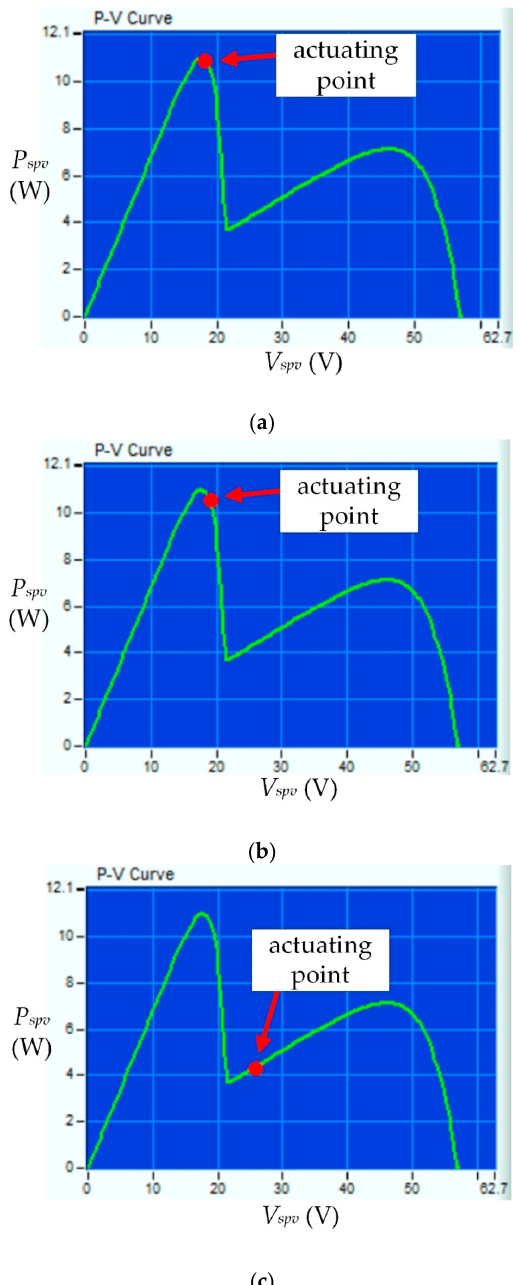
Figure 19 demonstrate the P spv − V spv curve of the SPVM under PSC at IL = 65 W/m 2 and temperature = 25 ◦ C. Figure 19a displays the experimental results of the proposed SLOPDM MPPT control strategy. First, uses the V spv , I spv , V o , and I o measurements. Second, angle θ 1 and MPPT duty cycle D were estimated using Equation (8) and Figure 9. The actuating point is accurately operated at MPP P mpp = 10.9 W like Figure 18a. Figure 19b,c are the results of the SAH and P&O algorithms, respectively. The SAH algorithm’s actuating point operated at P mpp = 10.3 W like Figure 18b. The P&O algorithm’s actuating point operated at P mpp = 3.9 W like Figure 18c.